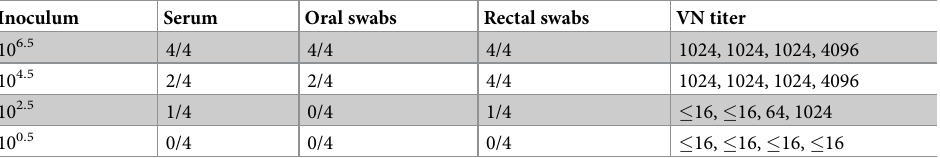
Table 2. Summary of finishing pig PCR positive status for each sample type throughout the study and VN titer for 14 dpi